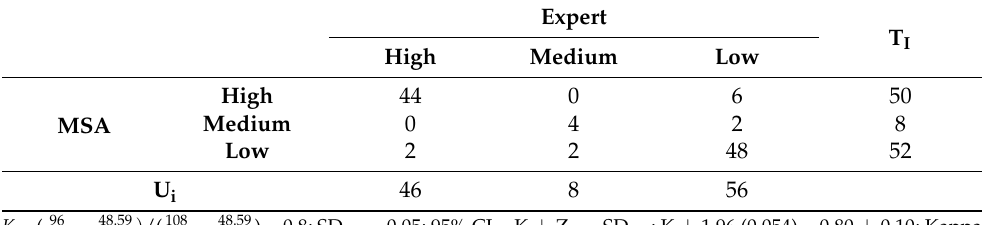
Table A5. Calculation of agreement of contact priority between MSA and the